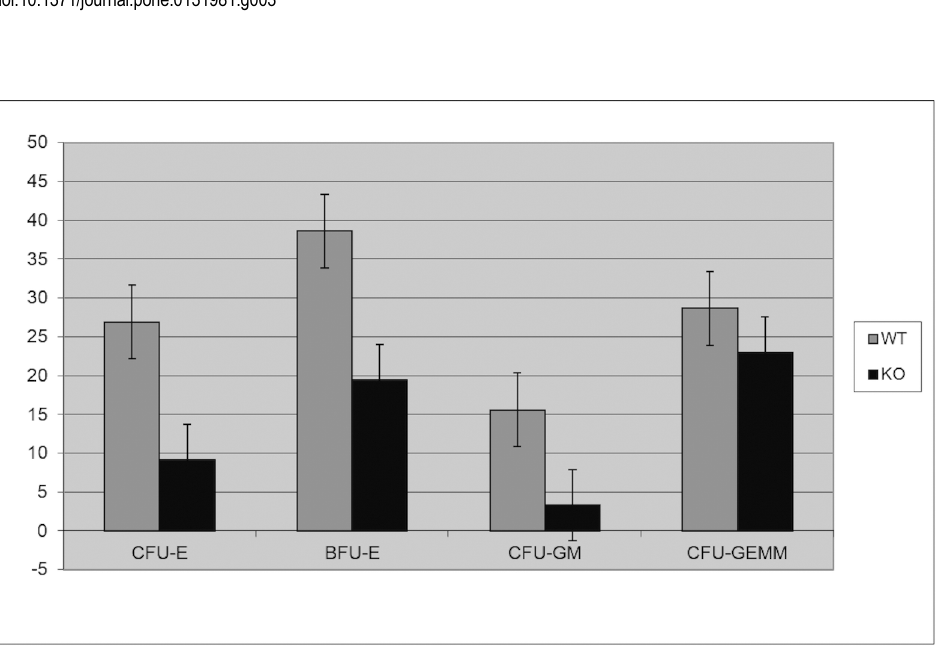
Fig 3. Histology of the spleen showing reduction of the myeloid lineage in the knockout versus the wild type.